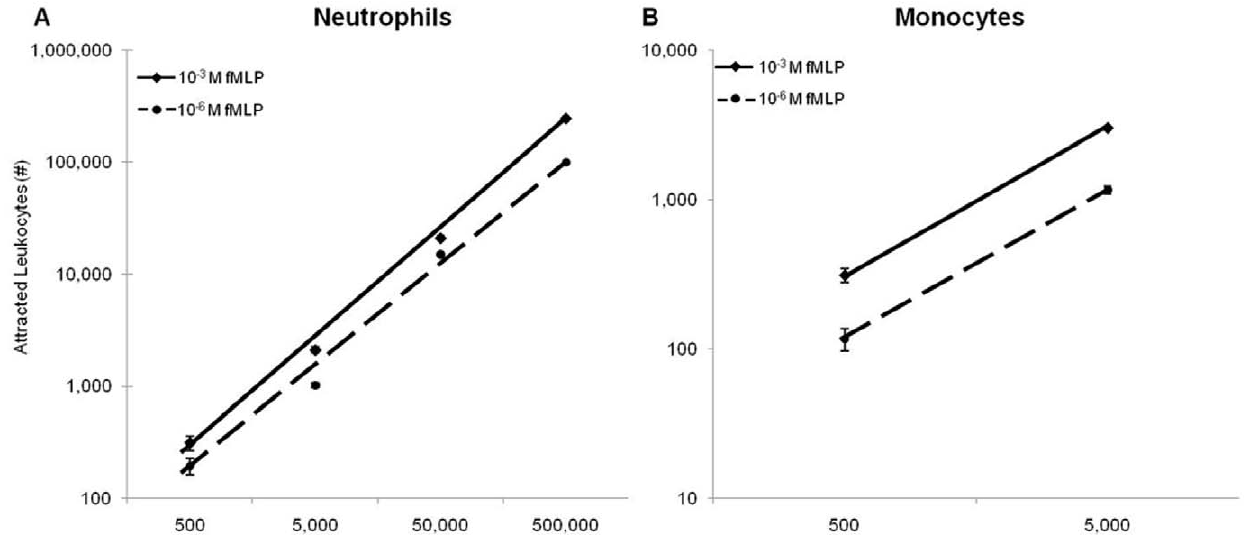
Figure 5. Linearity of CBFCA. CBFCAs were performed using 10 2 3 and 10 2 6 M fMLP as chemotactic and purified neutrophils ( A ) and monocytes ( B ) at different concentrations. The number of attracted neutrophils and monocytes increased lineally with the starting number of cells. Significantly more leukocytes were attracted by 10 2 3 M fMLP than by 10 2 6 M fMLP in all the cases. Data shown are means 6 SD of four independent assays in triplicate. Significance was determined by T test.